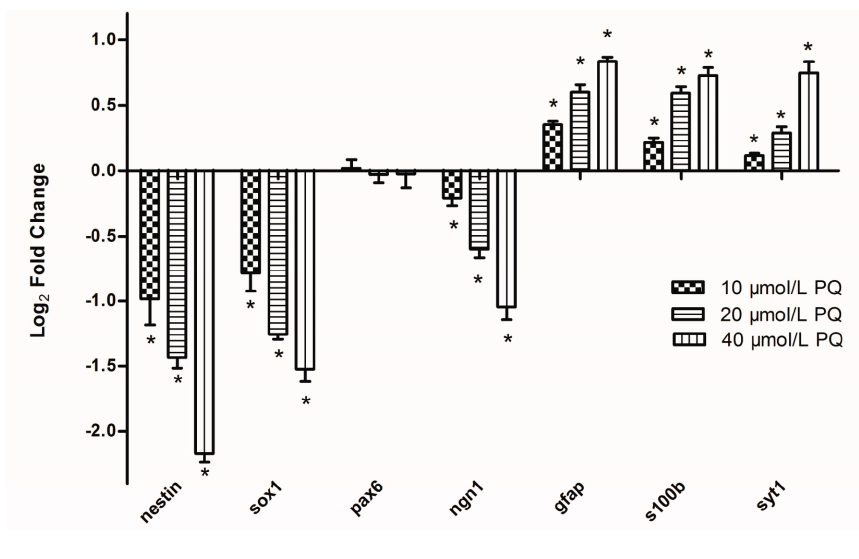
Figure 7. PQ-induced mRNA expression alterations. These genes selected from 1,465 targets of PQ-induced differentially expressed miRNA were known to be involved in the hNPCs proliferation and differentiation. hNPCs were treated with 0, 10, 20, or 40 μ mol/L PQ for 24 h and mRNA were isolated for real-time RT-PCR analysis. Data represent means ± SE with each analysis performed in triplicate. All values showed in the histograms are represented as log 2 fold change compared to the control group average of 0. * Indicate statistically significantly higher than that in the control group ( p < 0.05). n = 3 independent biological replicates for real-time